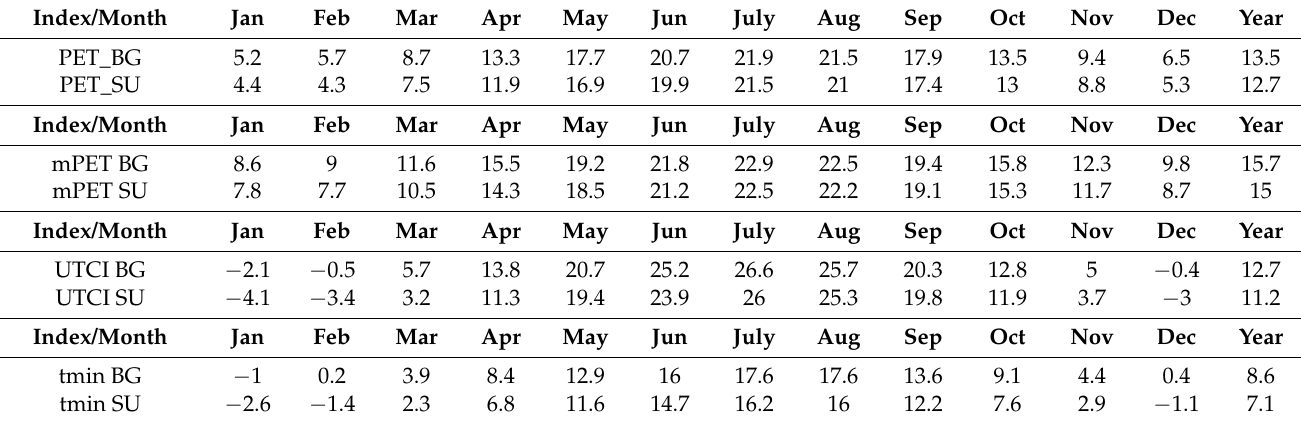
Table 2. Average monthly and annual PET, mPET and UTCI in Belgrade (BG) and Surˇcin (SU) for the period 1976–2018 at 7 h